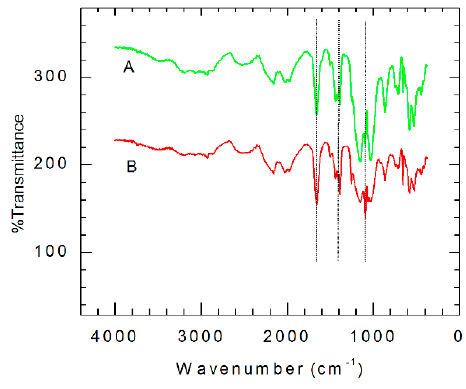
Figure 5. FTIR of: ( A ) GCE|SDD–Co(II); and ( B ) GCE|SDD–Co(II)|AgNPs.